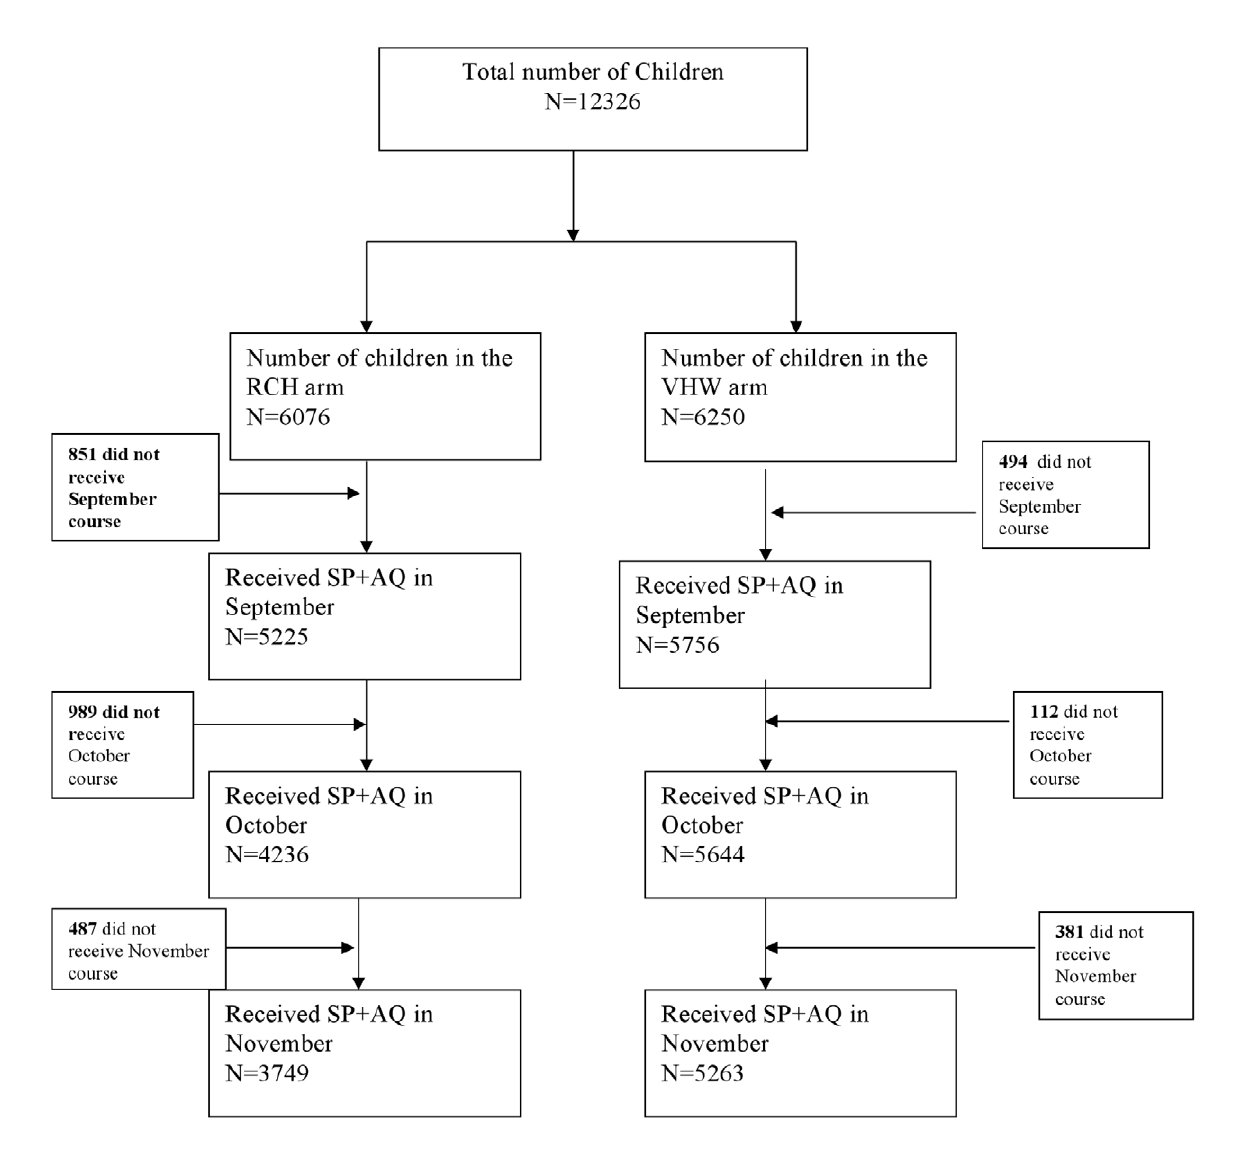
Figure 1. Trial profile.